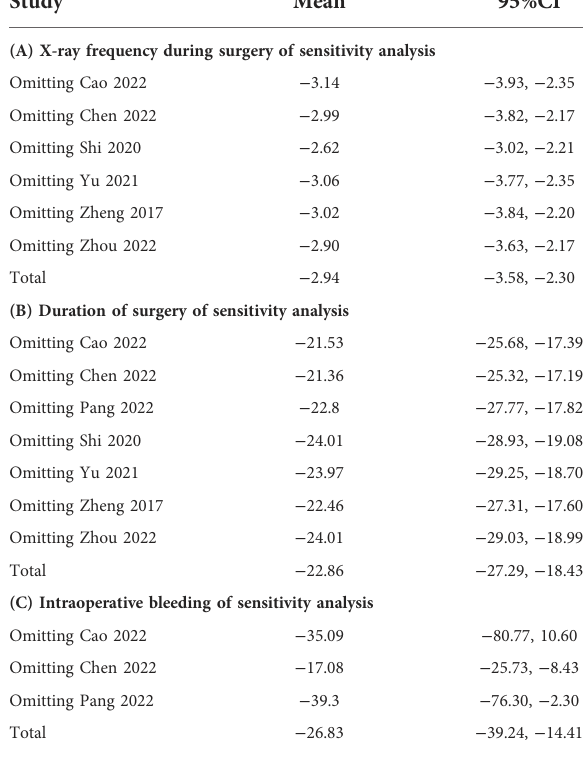
TABLE 2 The sensitivity analysis of the